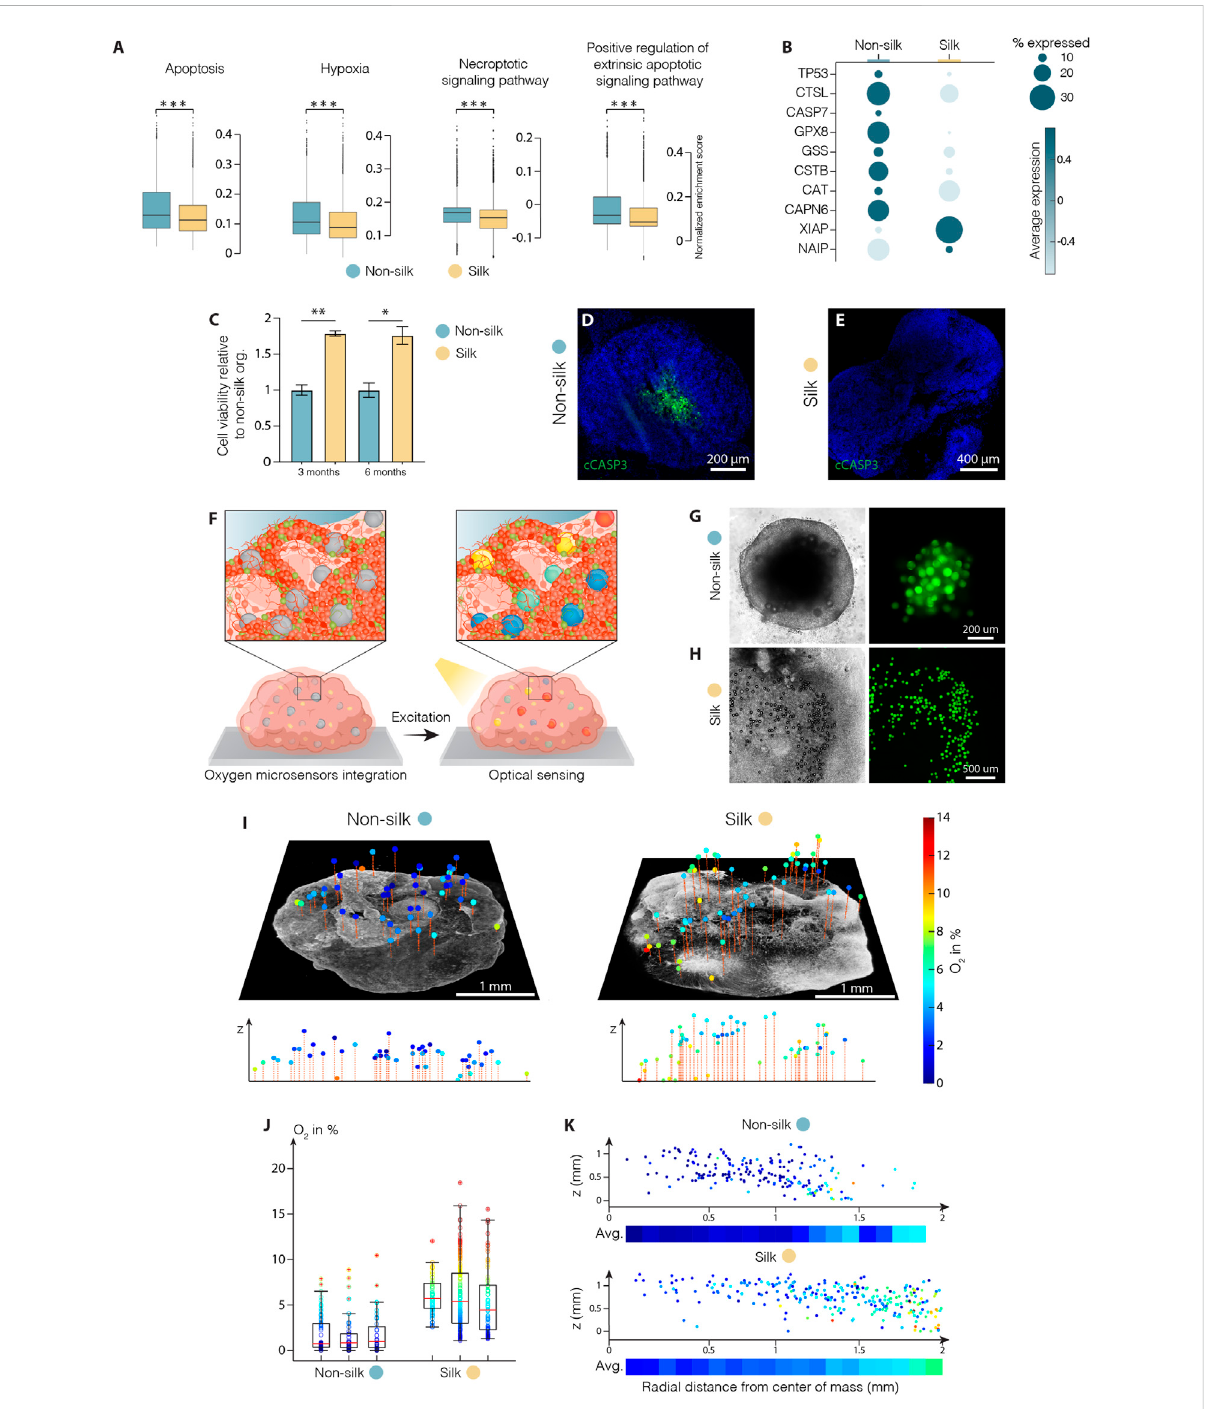
FIGURE 5 Silk scaffolding increases intra-organoid cell survival. (A) Apoptosis, hypoxia, necrosis signalling pathway analysis and (B) representative markers of cell death regulation in cerebral organoids grown with and without silk scaffold at 4 months *** p < 0.001, two-tailed Wilcoxon rank sum test. (C) Cell viabilityincerebralorganoidsgrownwithandwithoutscaffoldmeasuredbyMTTassayandexpressedasrelative fl uorescenceunits(RFU).Datarepresent mean±SEM,normalizedovernon-silkorganoids(n=3).* p < 0.05,** p < 0.01,two-tailedMannWhitneytest. (D,E) Immunohistochemistryofcleaved caspase 3 in non-silk (D) and silk (E) organoids at day 120. Scale bars 200 µm (D) and 400 μ m E). (F) Schematic illustration of oxygen tension measurements in human brain organoid. (G,H) Representative bright- fi eld images of non-silk (G) and silk (H) brain organoids with integrated CPOx-50- Ptp oxygen sensor beads 8 days after seeding. Scale bars 200 μ m G) and 500 μ m H). (I) 3D oxygen maps of non-silk and silk organoids with simultaneously acquired co-localizedlivecell images and their cross-sectionaloxygendistribution.Scale bars 1 mm. (J) Oxygen distributionin 3 silkand non-silkorganoidsatday60showingaverageoxygenation(redline)and25thand75thpercentile(box). (K) Ratioofoxygentensiontoheightanddistance fromorganoidcenteraxisinsilkandnon-silkorganoids,andheatmapofaverageoxygenlevelforevery100